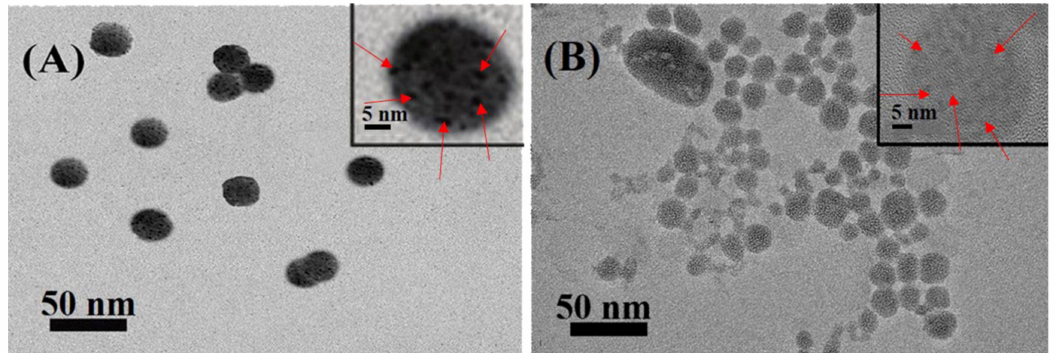
Figure 5. TEM images of M6@CdTe / ZnS with di ff erent M6-3 / QDs ratio: 1:10 ( A ) and 1:50 ( B ). (Insert: HRTEM of single M6@CdTe / ZnS, the scale bar refers to 5